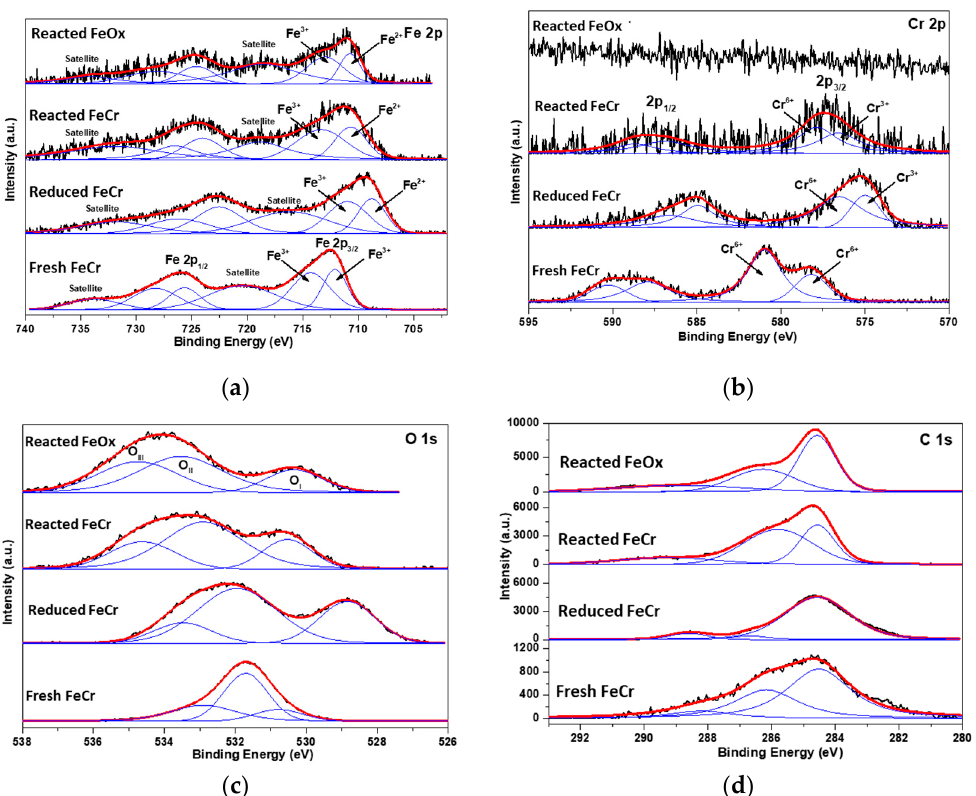
Figure 3. XPS spectra of the FeCr catalyst samples at various stages of processing: ( a ) the Fe 2p XPS spectra, ( b ) the Cr 2p core ‐ level XPS spectra, ( c ) the O 1s spectra, and ( d ) the C 1s spectra.